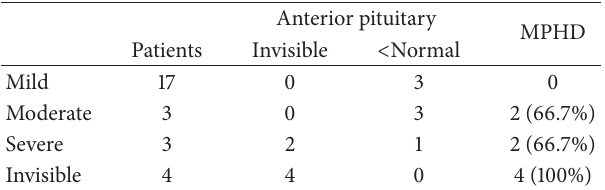
Table 3: Pituitary function of 27 patients with abnormal pituitary stalk ∗